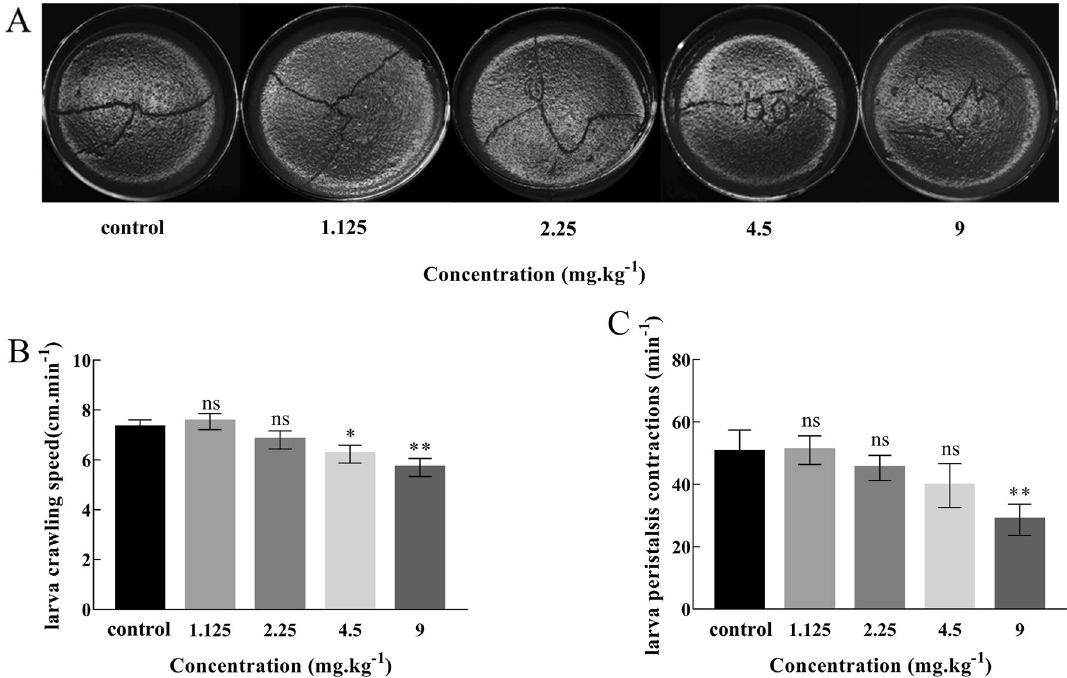
Figure 4. Crawling behavior of third instar larvae of Drosophila . ( A ) Photographs of third instar larvae crawling route. ( B ) Larvae crawling speed at increasing Cd concentrations. ( C ) Larvae peristalsis contractions at increasing Cd concentrations. (Mean ± SD, n = 3, 15 larvae per sample, * P < 0.05, ** P < 0.01, ns = not significant).